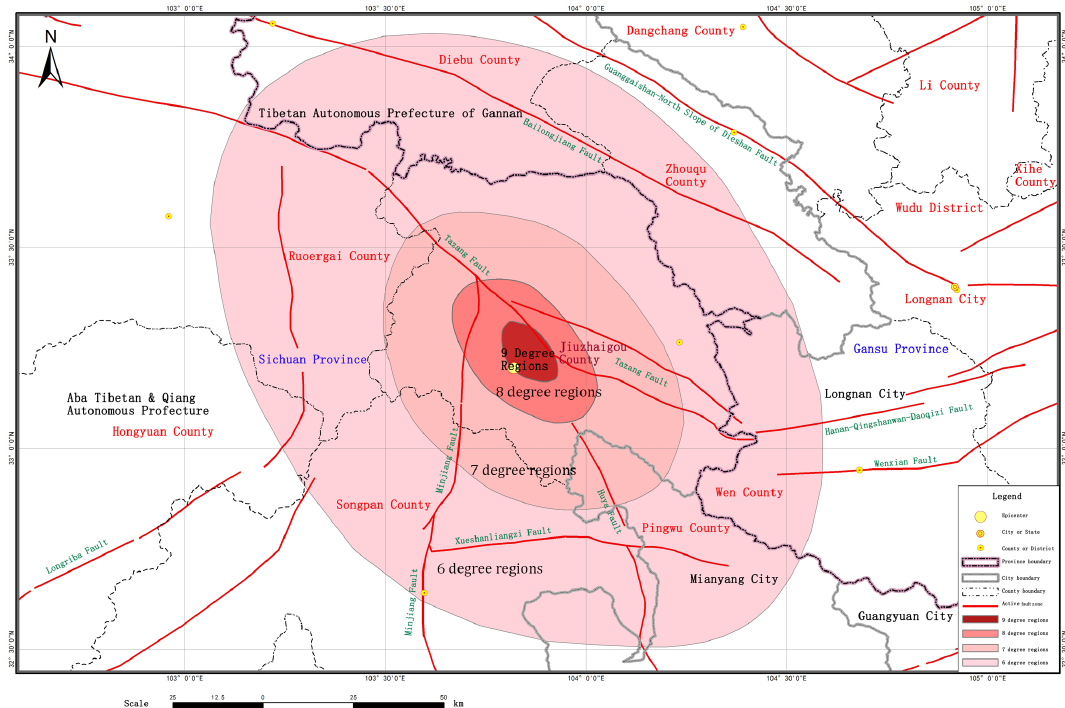
Figure 1. Seismic intensity map of the M s 7.0 earthquake that occurred in Jiuzhaigou County, Sichuan Province.